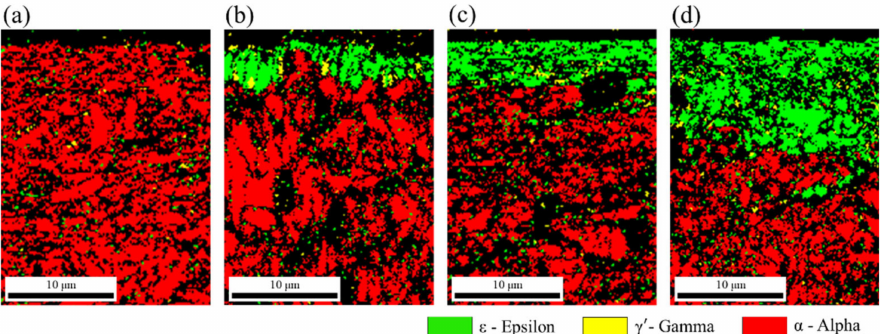
Figure 5. EBSD phase maps analyzed near the compound layer of the nitrided specimens after nitriding at 520 ◦ C for 10 h at K n = ( a ) 0.2, ( b ) 1.0, ( c ) 2.0, and ( d ) 5.0 atm − 1/2